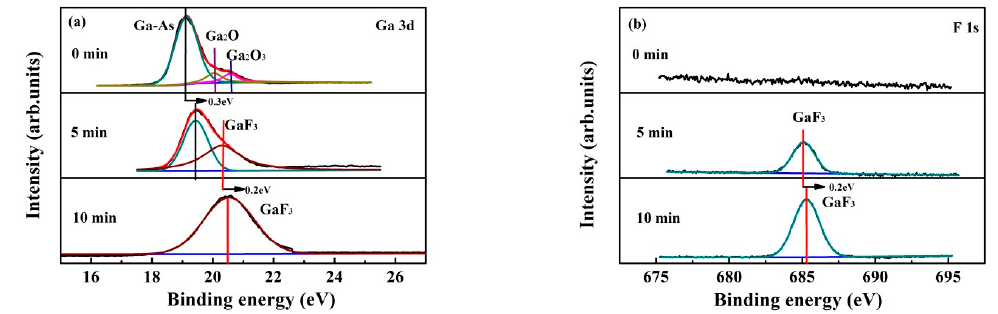
Figure 6. XPS analysis of the GaAs surface by using different SF 6 plasma treatment for 0 min, 5 min, and 10 min, ( a ) Ga 3d and ( b ) F 1s.